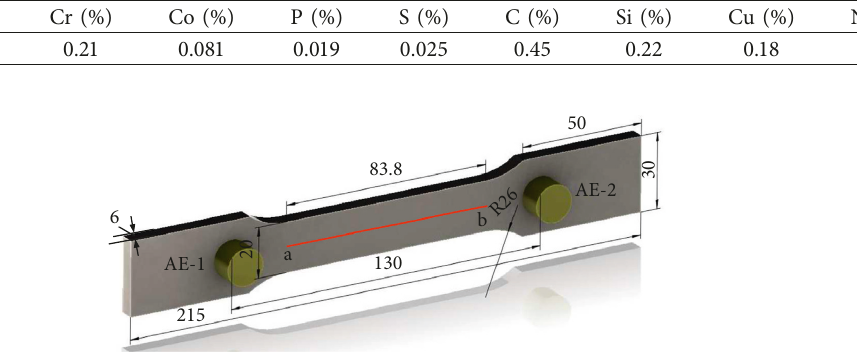
Figure 3: Specimen size (unit: mm).